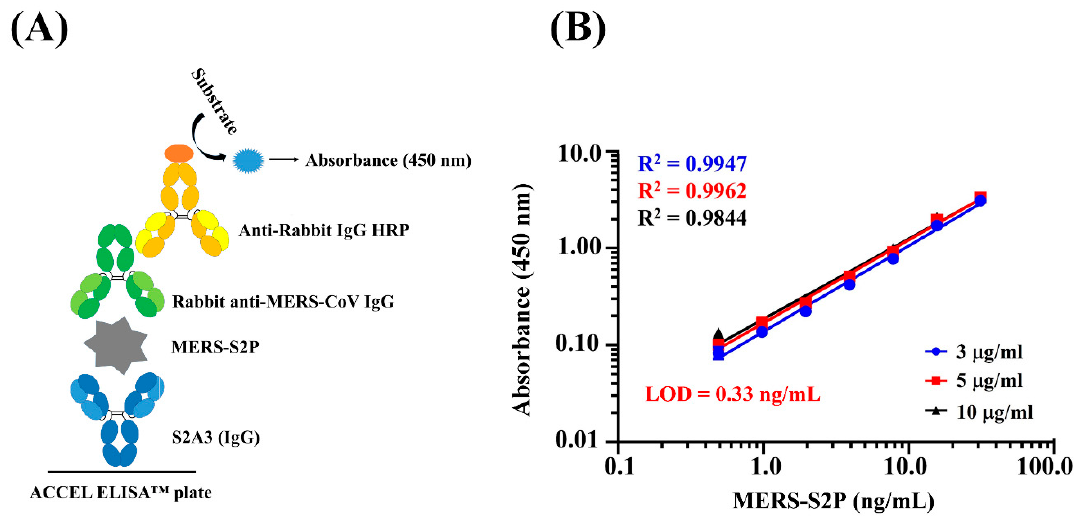
Figure 5. Detection of MERS-S2P using S2A3 (IgG) on ACCEL ELISA™ plates. ( A ) Schematic depicting the sandwich ELISA format to detect MERS-S2P using S2A3 (IgG) (capture antibody) and rabbit anti-MERS-CoV IgG (detection antibody) on ACCEL ELISA™ plates. ( B ) ELISA detection of MERS-S2P on a capture antibody (S2A3 (IgG)) immobilized using three different concentrations (3 μ g/mL, 5 μ g/mL, and 10 μ g/mL) on ACCEL ELISA™ plates. The goodness of fit is indicated by the R 2 value. LOD, limit of detection.